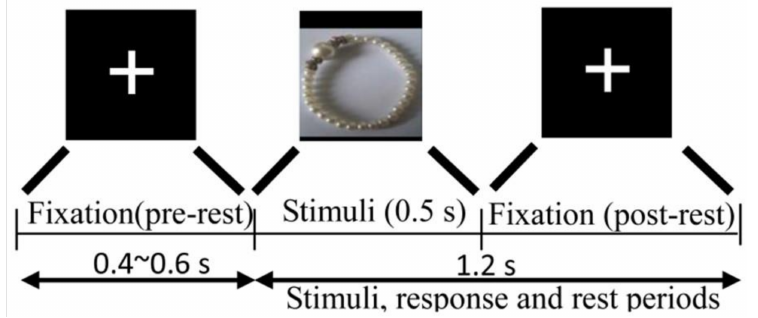
Figure 2. Schematic diagram of stimulus presentation in the